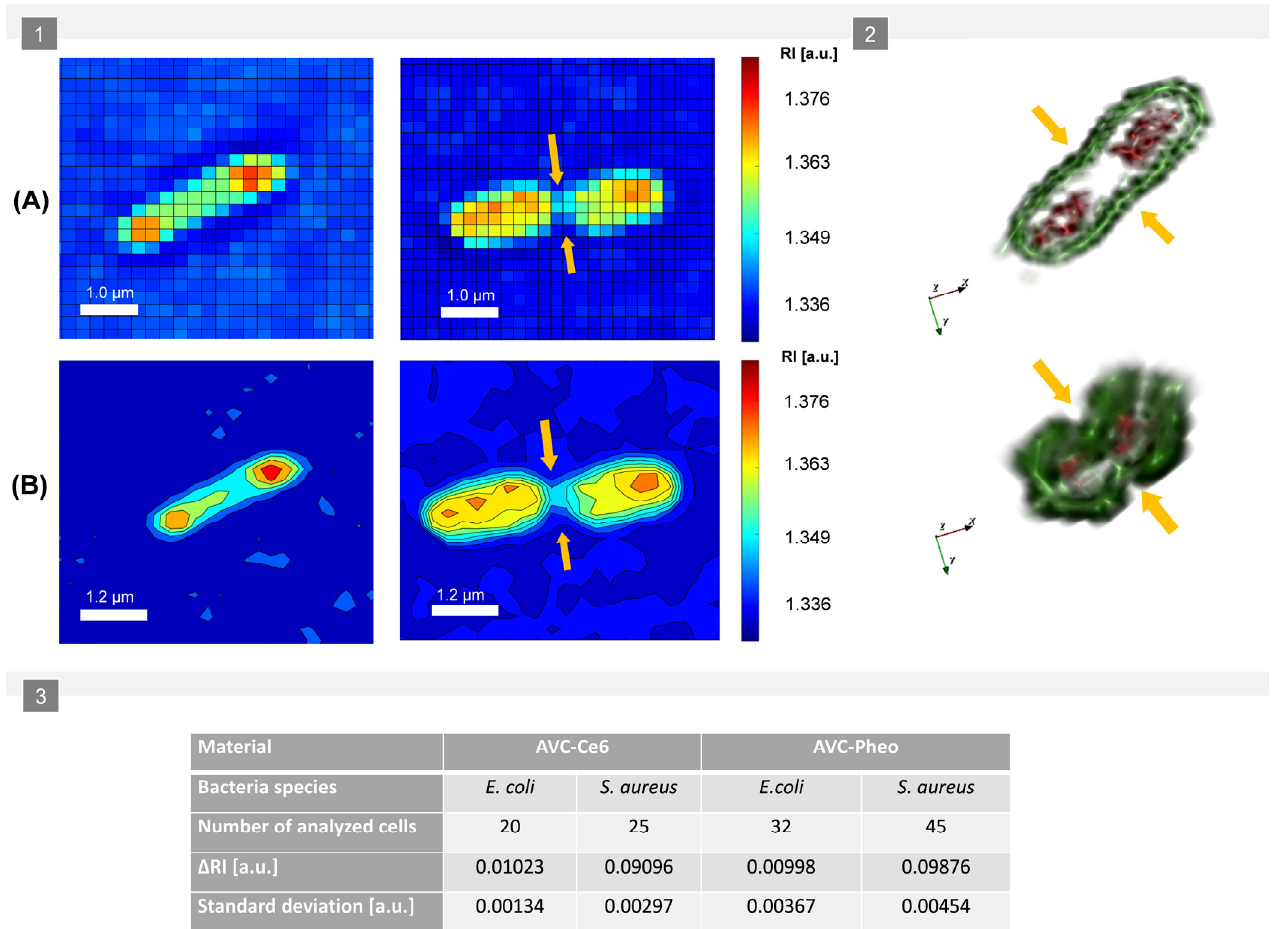
Figure 6. Bacteria single-cell division. ( 1 ) The exemplary results demonstrating the process of E. coli cell division by changes of its RI values: the representative average 3D-RI distribution of single-cell ( A ) and distribution of averaged 3D-RI isolines ( B ) demonstrating the process of accumulation of the cytoplasmic components on two opposite ends of the cell and the nearly complete synthetization of the septum revealed by RI data (orange arrows indicate the septum location characteristic for one of the last stages of the cell division); ( 2 ) the exemplary rendered and digitally stained E. coli and S. aureus dividing cells from their reconstructed 3D-RI distributions (red—corresponding to the highest RI values of cell interior, green—corresponding to the lowest RI values of the outer regions of the cell); ( 3 ) the changes of the averaged RI between non-dividing and dividing cells on the surface of different photoexcited materials (AVC-Ce6, AVC-Pheo). However, the number of cells able to divide was limited among different analyzed samples. As in the previous case, an ANOVA analysis was performed to check whether